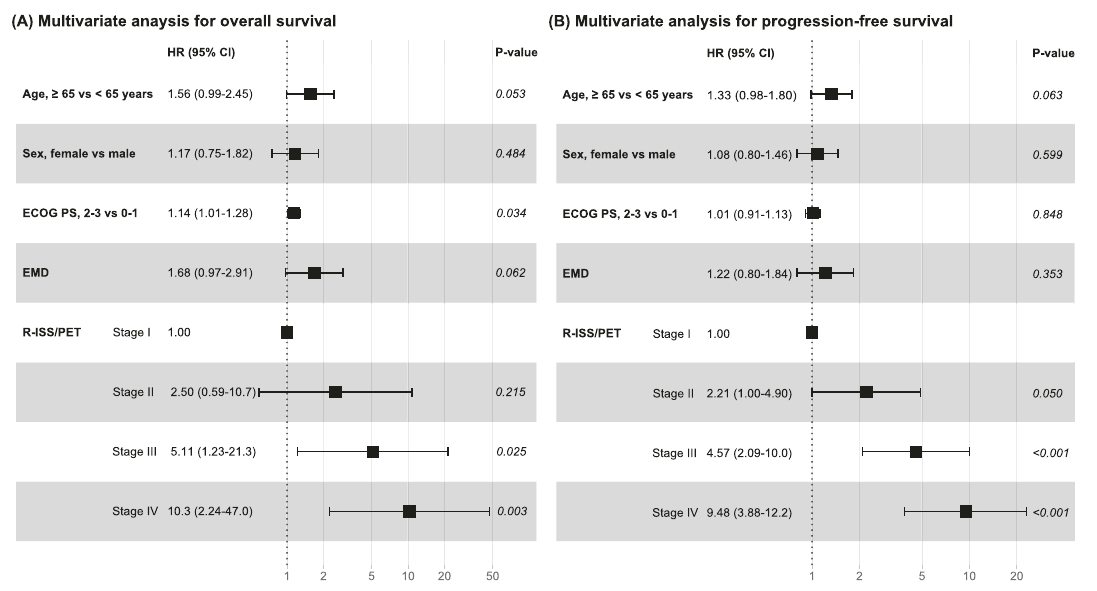
Fig. 3 Multivariate analyses for overall survival and progression-free survival with the R-ISS/PET. Abbreviation: R-ISS/PET Revised International Staging System/positron emission tomography, HR hazard ratio, CI con fi dence interval, ECOG PS Eastern Cooperative Oncology Group performance status, EMD extramedullary disease.